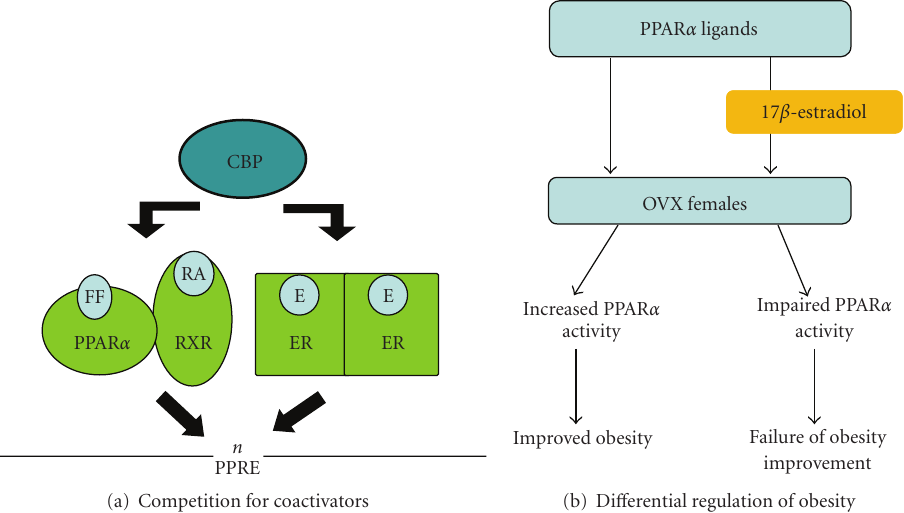
Figure 7: Mechanism of inhibitory e ff ect of 17 β - estradiol on PPAR α -mediated regulation of obesity. (a) Competition between PPAR α and estrogen receptors (ERs) for coactivator binding. 17 β -estradiol-activated ERs can interfere with the PPRE binding of PPAR α. (b) Inhibition of PPAR α actions on obesity by E . E impairs the ability of PPAR α ligands to reduce body weight gain and adiposity in female ovariectomized (OVX) mice. FF: fenofibrate; RA: 9 cis-retinoic acid; RXR: retinoid X receptor. Adapted from